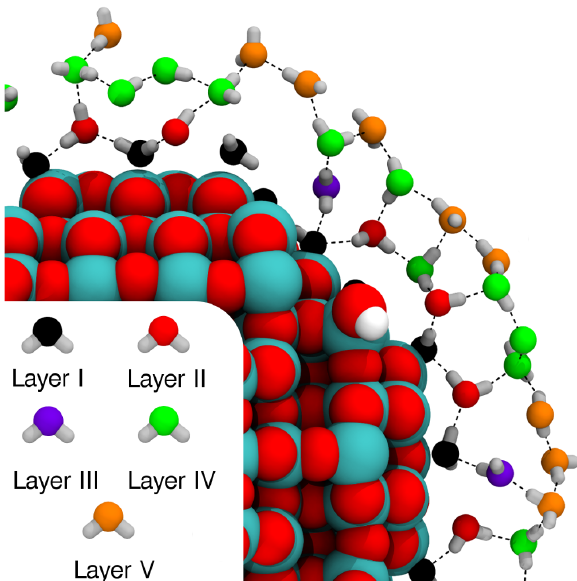
Figure 7. Top view of the cross-section of the water multilayer on the NP model after QM / MM geometry optimization. Oxygen atoms of the adsorbed water molecules and OH groups are color-coded according to their distance from the closest titanium atom. Titanium, oxygen, and hydrogen atoms of the nanoparticle are shown as cyan, red, and white spheres, respectively. Hydrogen bonds are represented by dashed black